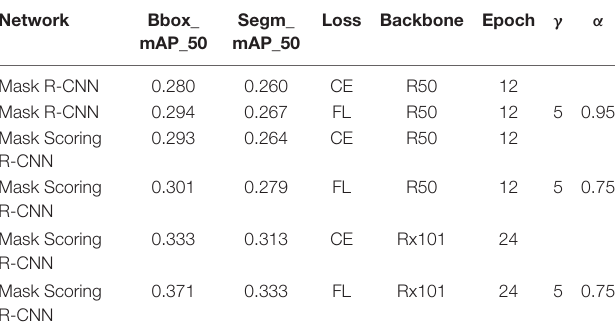
TABLE 9 | Training parameters and test results on original